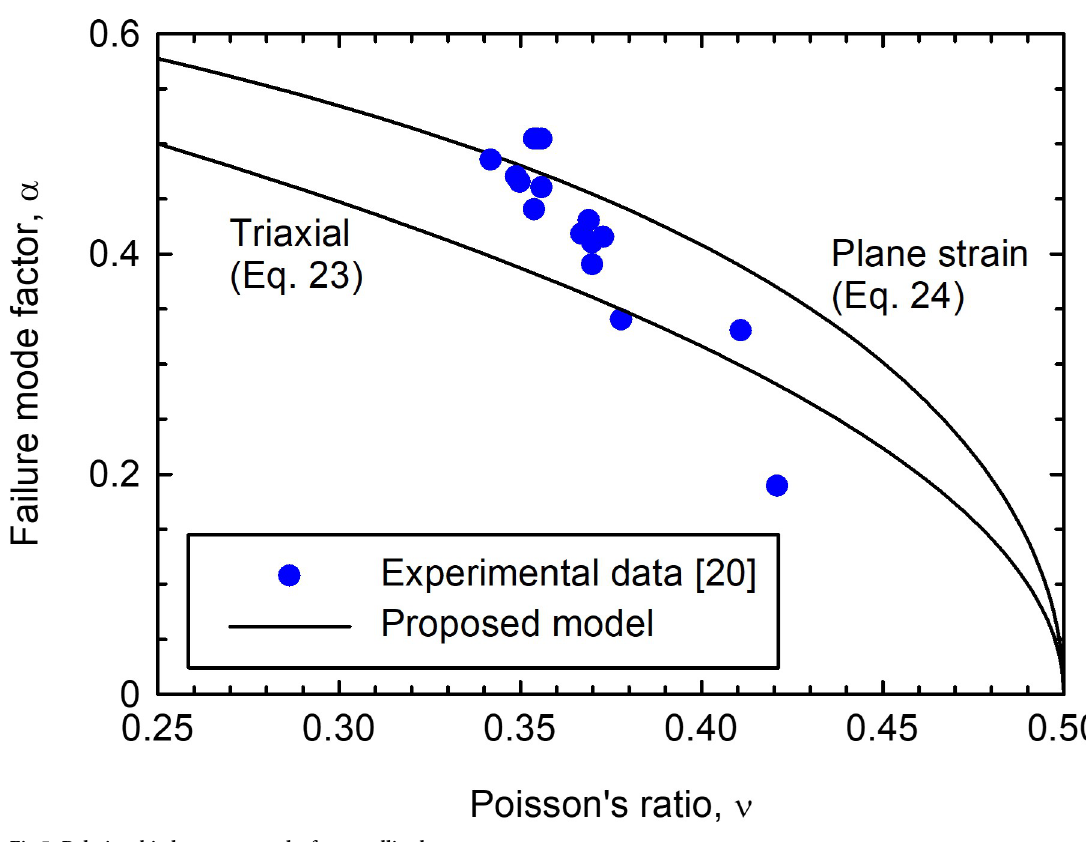
Fig 5. Relationship between α and ν for metallic glasses.